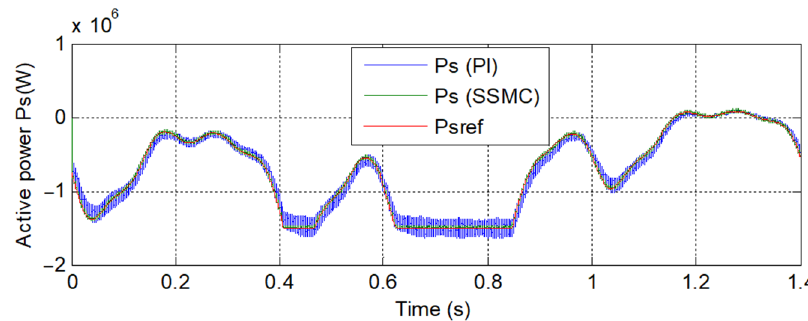
Figure 15. Active power.